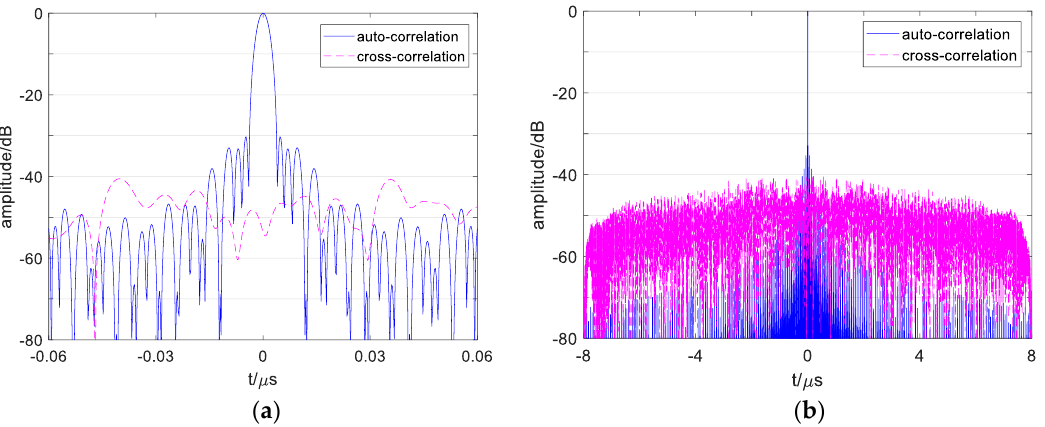
(cid:48) and s (cid:48) . ( a ) Correlation curve of s ' s . ( a ) Correlation curve of Figure 11. Correlation curve of designed OFDM chirp signals s ' s and 2 1 2 1